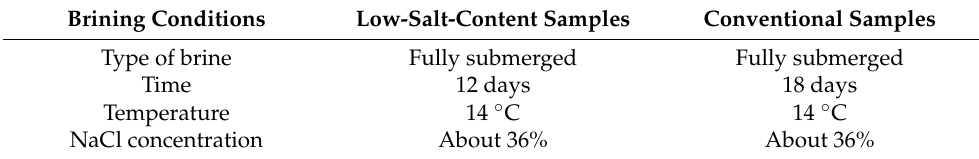
Table 1. Brining